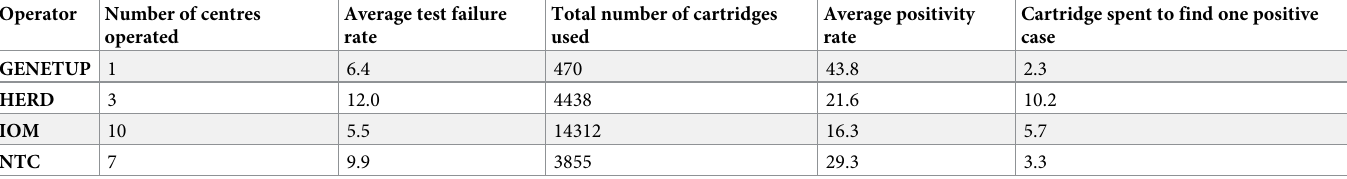
Table 3. Average annual performance score of centres according to their operators in Nepal, 2015–2016.